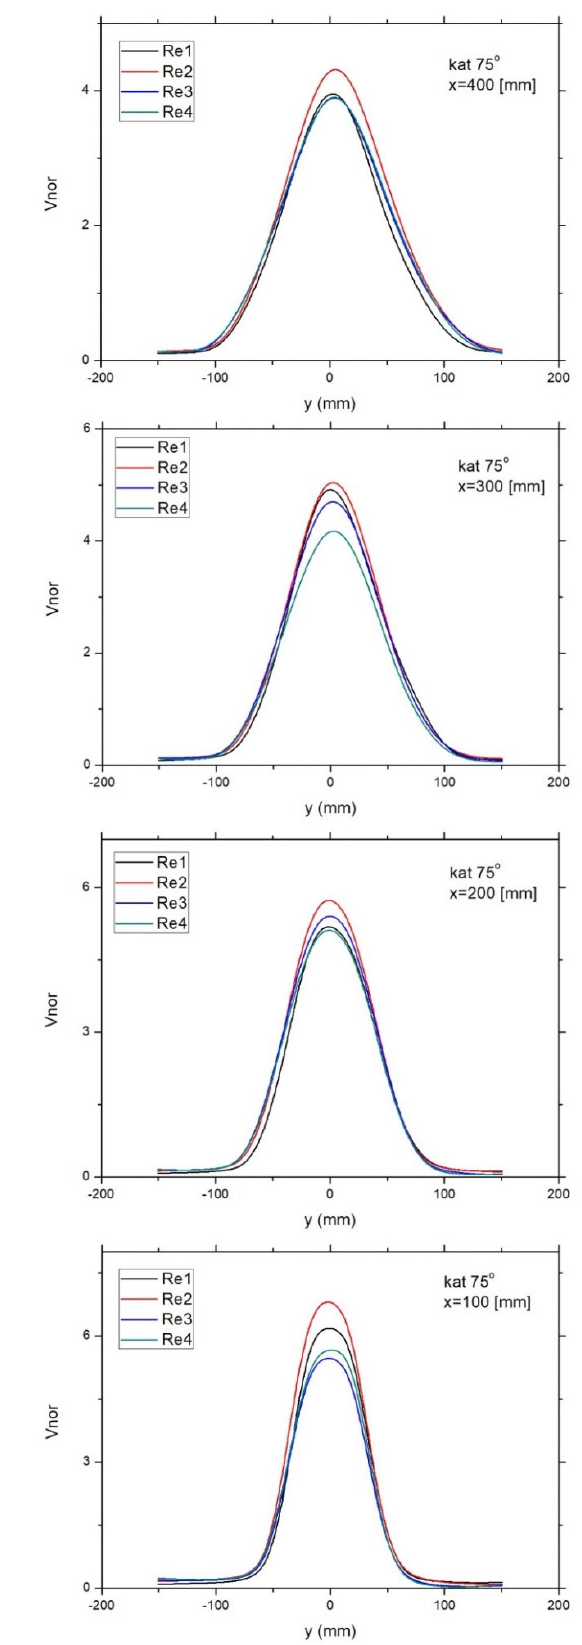
Fig. 8 . Standardized profiles of air velocity flowing out of the diffuser with vanes directed at an angle of 75° at different distances (x = 100 ÷ 400mm) from the outlet of the